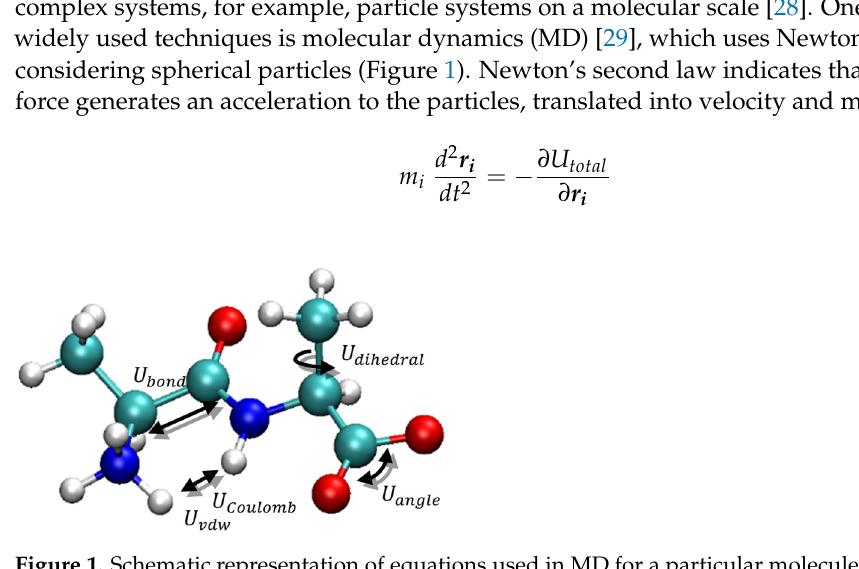
Figure 1. Schematic representation of equations used in MD for a particular